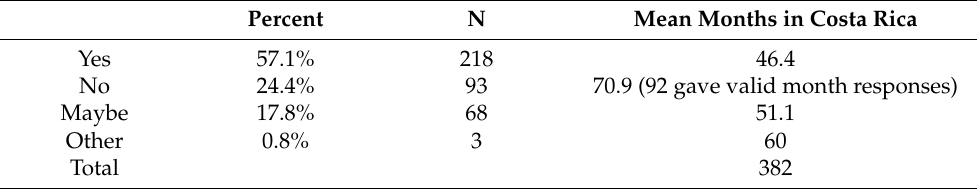
Table 4. Desire of migrants to return to Nicaragua (data from the 1999 Costa Rica study).